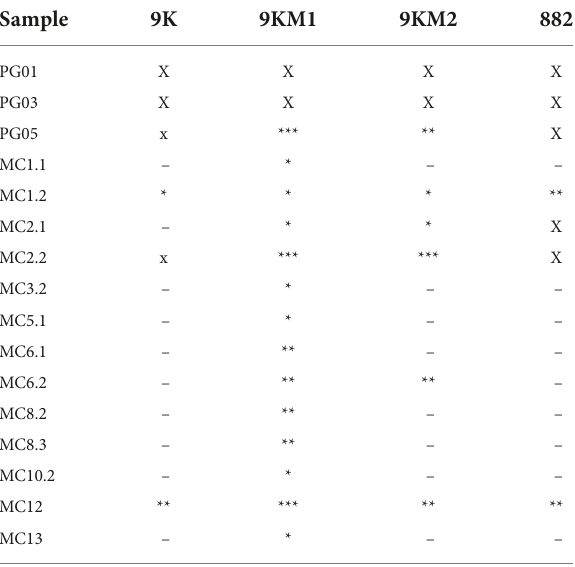
TABLE 2 Evaluation of the bacterial growth of the samples in the different acid culture media.